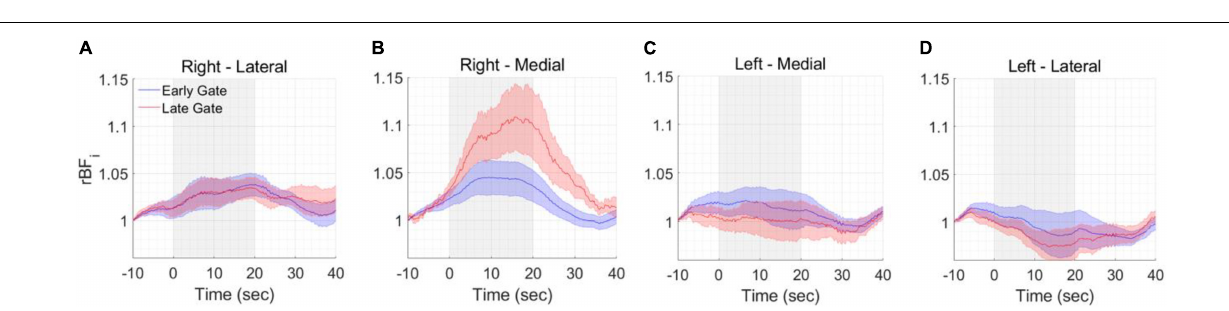
FIGURE 7 | Functional measurements. BF i changes during the different tasks were averaged across all included trials and all included subjects at the (A) right lateral, (B) right medial, (C) left medial and (D) left lateral locations. A statistically significant response was found at the right-medial location. The shaded area represents the standard error of the six subjects. The gray area represents the duration of the